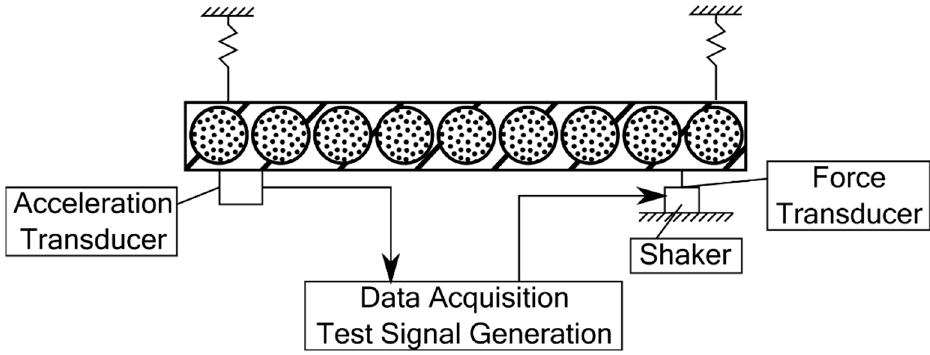
Figure 2. Possible Measurement setup for transient excitation.